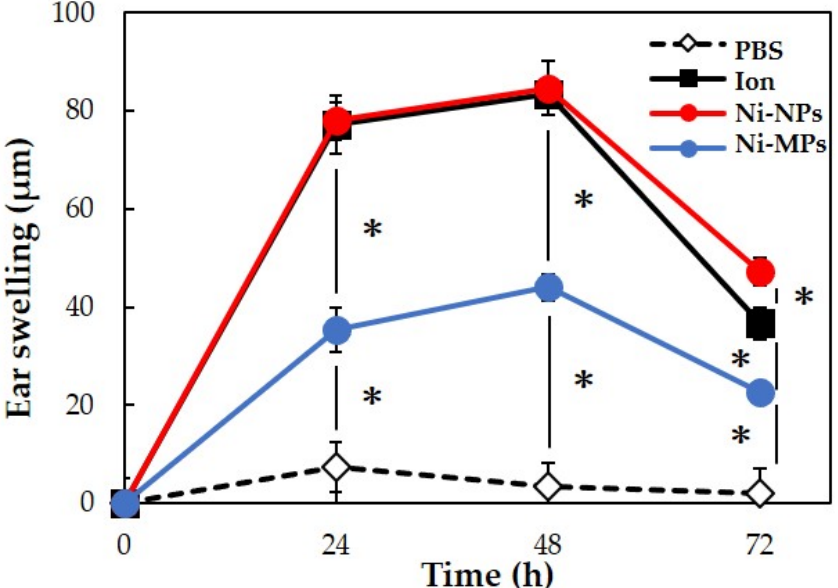
Figure 7. Comparison of auricular swelling after nickel allergy elicitation. Data are presented as the mean ± S.D. * denotes statistical significance p < 0.05.